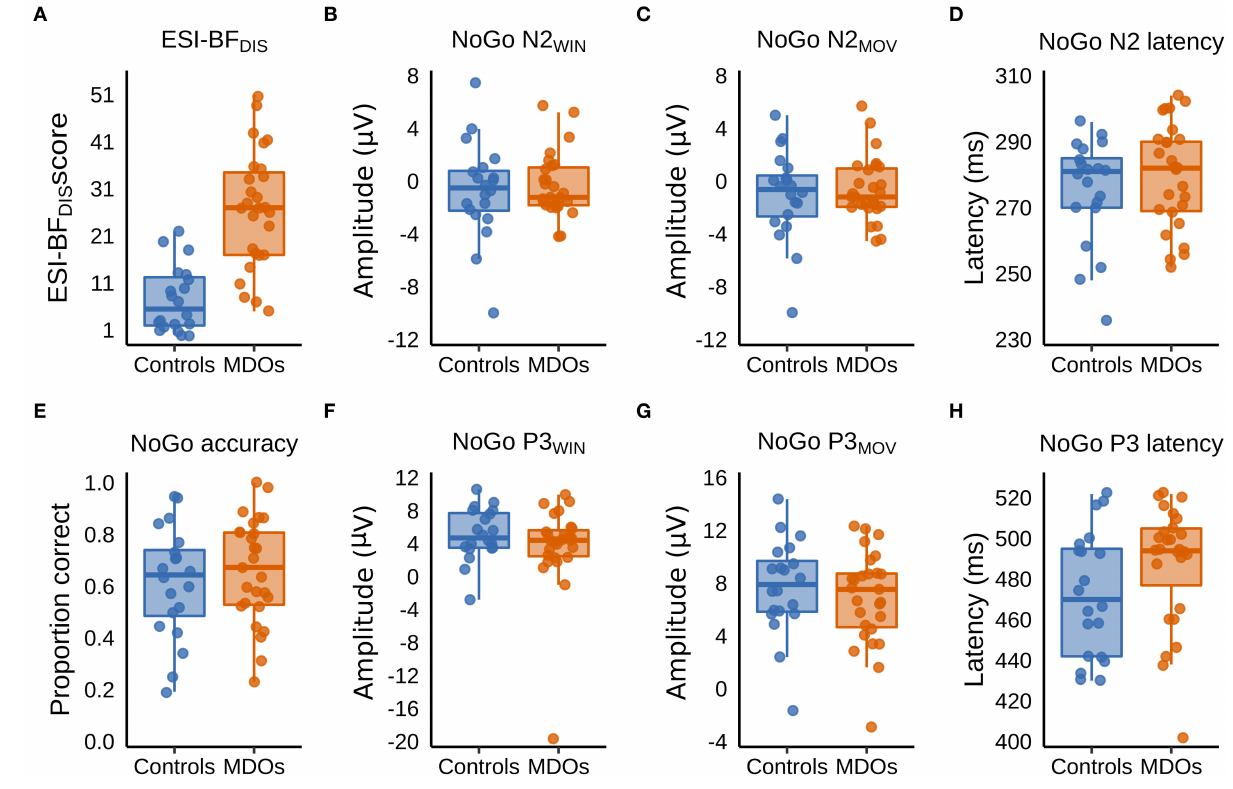
FIGURE 2 | (A–H) Boxplots showing group differences in trait disinhibition, experimentally assessed response inhibition, and event-related potentials. ESI-BF DIS , Externalizing Spectrum Inventory-Brief Form, General Disinhibition subfactor; MDO, mentally disordered